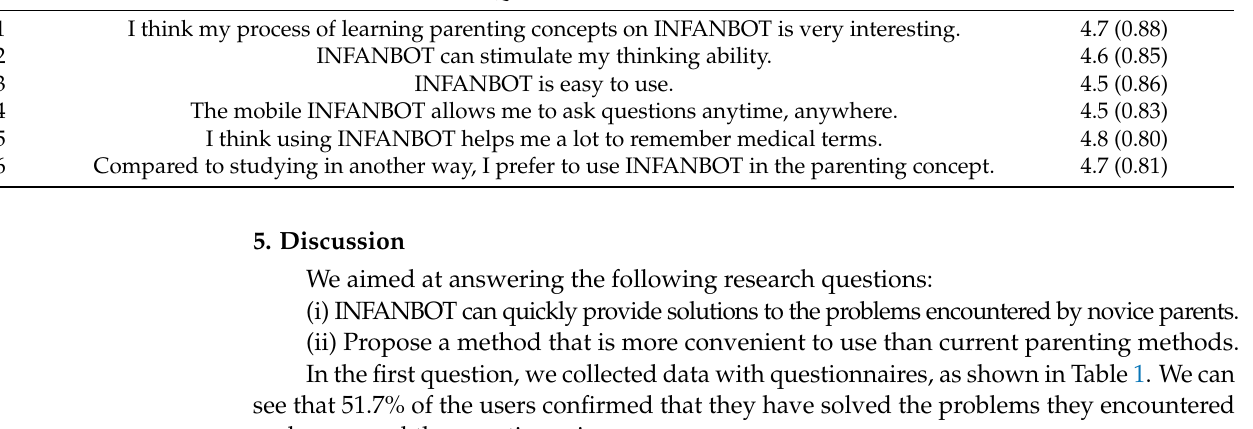
Table 2. The results of the usability test and satisfaction survey of INFANBOT.